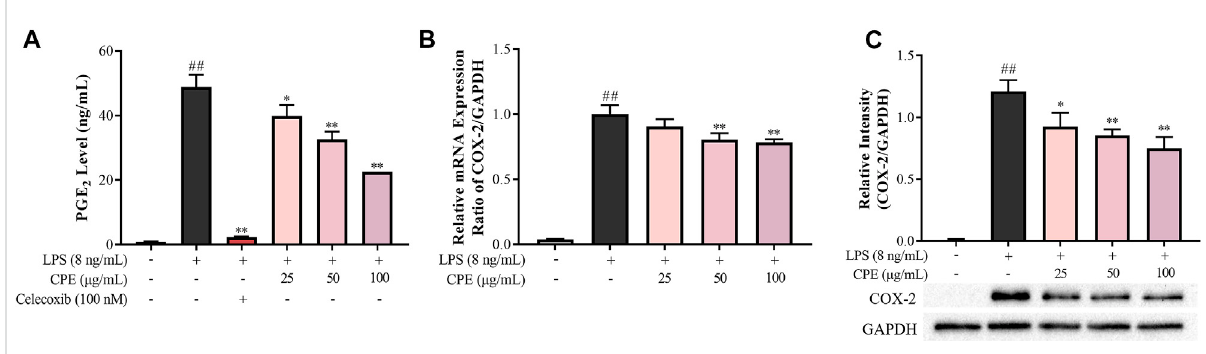
FIGURE 6 Effect of CPE on PGE 2 production in LPS-stimulated RAW264.7 macrophages ( n = 3). (A) Effect of CPE on supernatant PGE 2 in LPS-activated RAW264.7 macrophages. Cells were incubated with LPS (8 ng/ml) with or without CPE for 24 h. PGE 2 level in the supernatant was then detected by ELISA.Celecoxibwasusedasapositivecontrol. (B) EffectofCPEonCOX-2mRNAexpression.RAW264.7macrophagesweretreatedwithLPS(8 ng/ ml) with or without CPE at the indicated concentrations for 4 h. Total mRNA was then extracted. The mRNA level of COX-2 was determined by RT-qPCR. (C) Effect of CPE on COX-2 protein expression. RAW264.7 macrophages were treated with LPS (8 ng/ml) in the absence or presence of CPE for 24 h. Total intracellular protein was then extracted, and the COX-2 protein level was assayed by Western blot. ## p < 0.01 vs. normal control group; * p < 0.05 and ** p < 0.01 vs. LPS alone group.